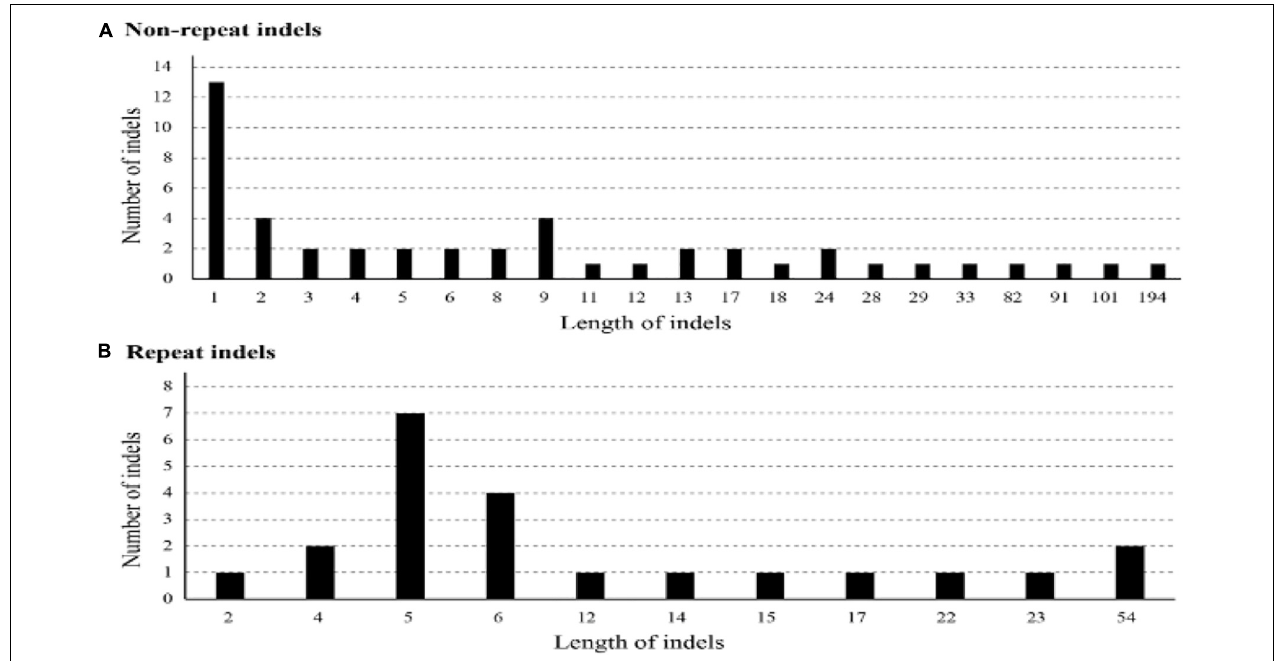
FIGURE 3 | Number of non-repeat InDels (A) and repeat InDels (B) of each length in Z. jujuba chloroplast genome.